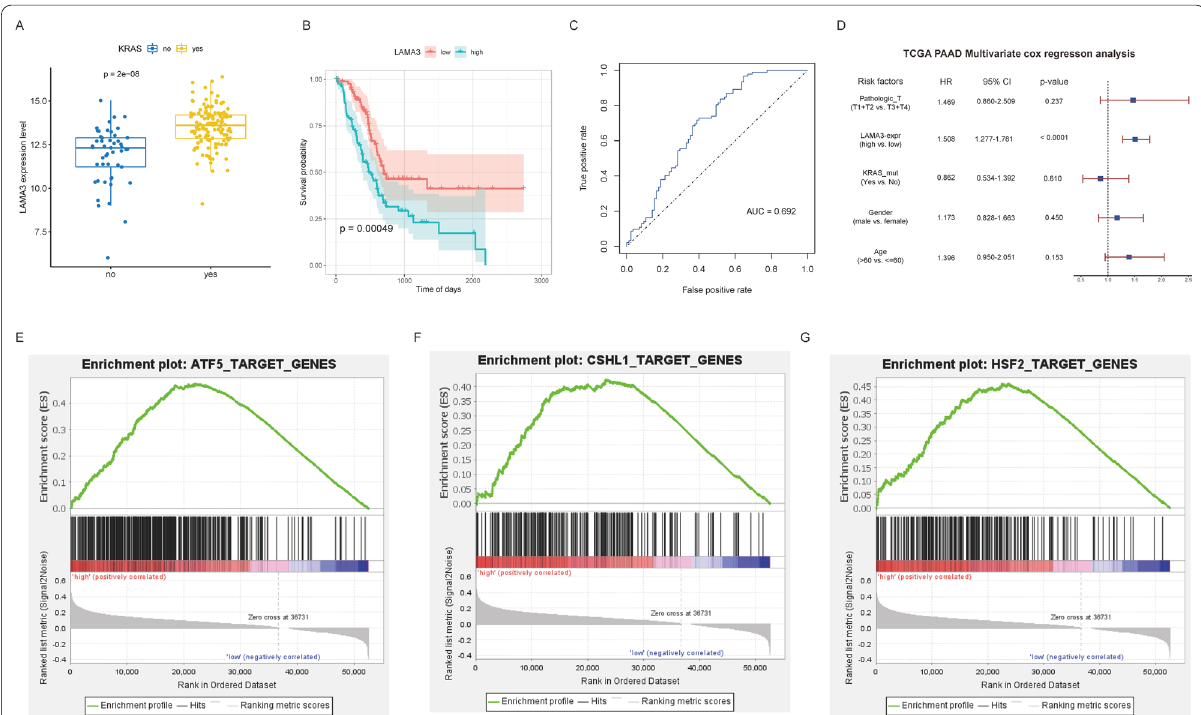
Fig. 10 A Distribution of LAMA3 expression in KRAS mutation groups. B KM curves to compare the overall survival between high-LAMA3 and low-LAMA3 samples. C ROC curve for prognosis based on LAMA3 expression. D Multivariate Cox regression analysis based on LAMA3